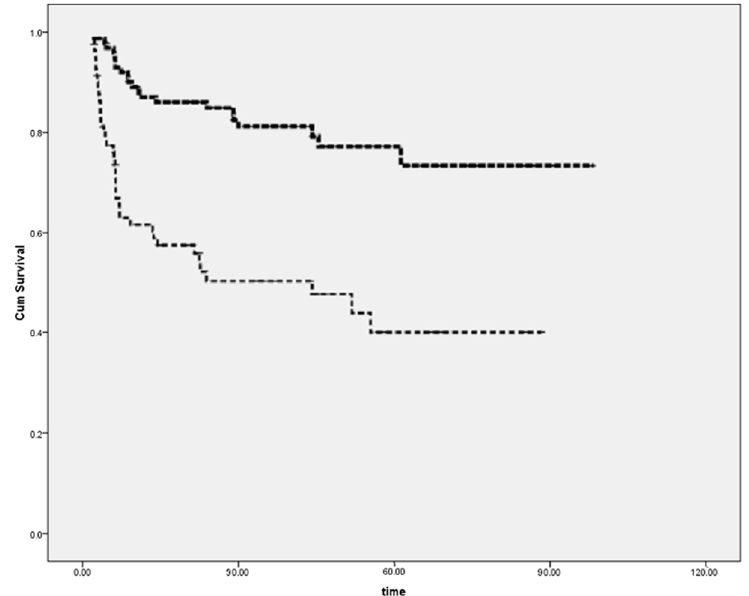
Figure 1. Kaplan Meyer Survival curve according to endomyocardial biopsies (EMB) (virus positive EMB in thick dashed line and virus-negative EMB in thin dashed line) ( p < 0.001, see text for explanation).